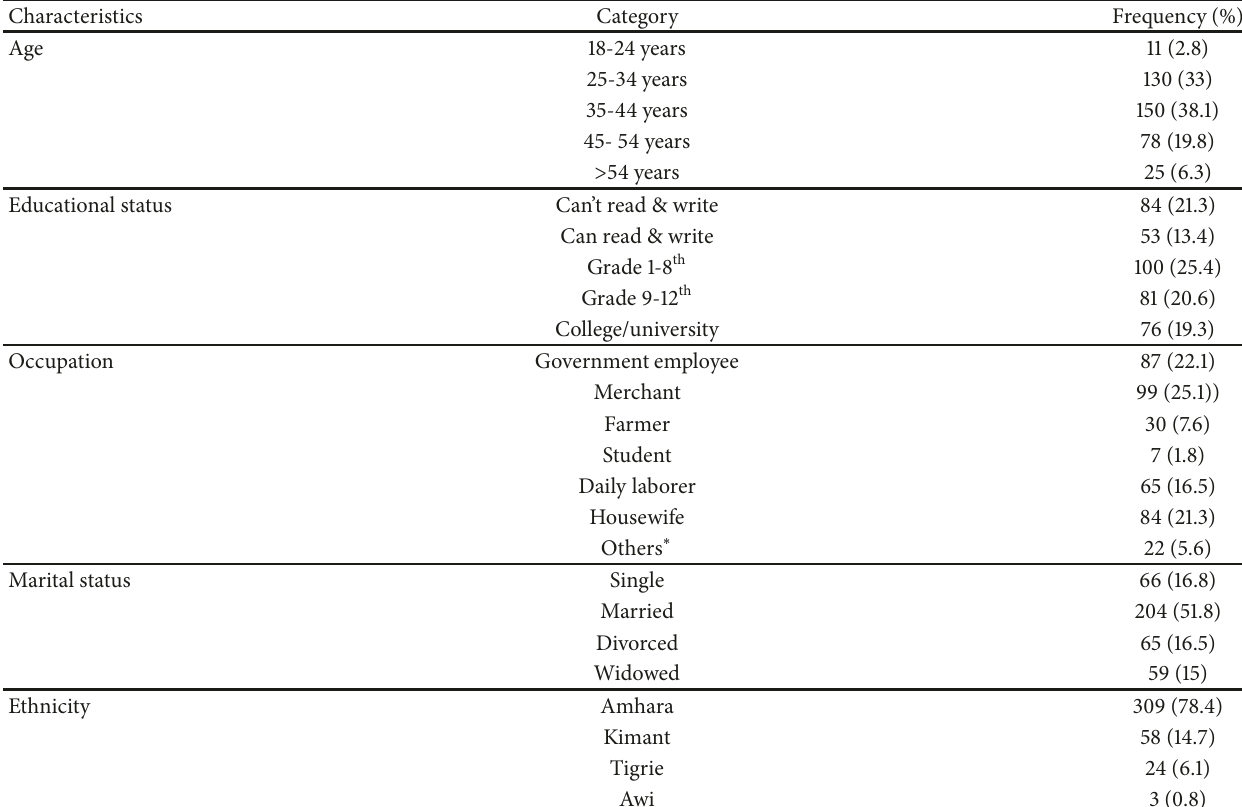
Table 1: Sociodemographic characteristics of the study